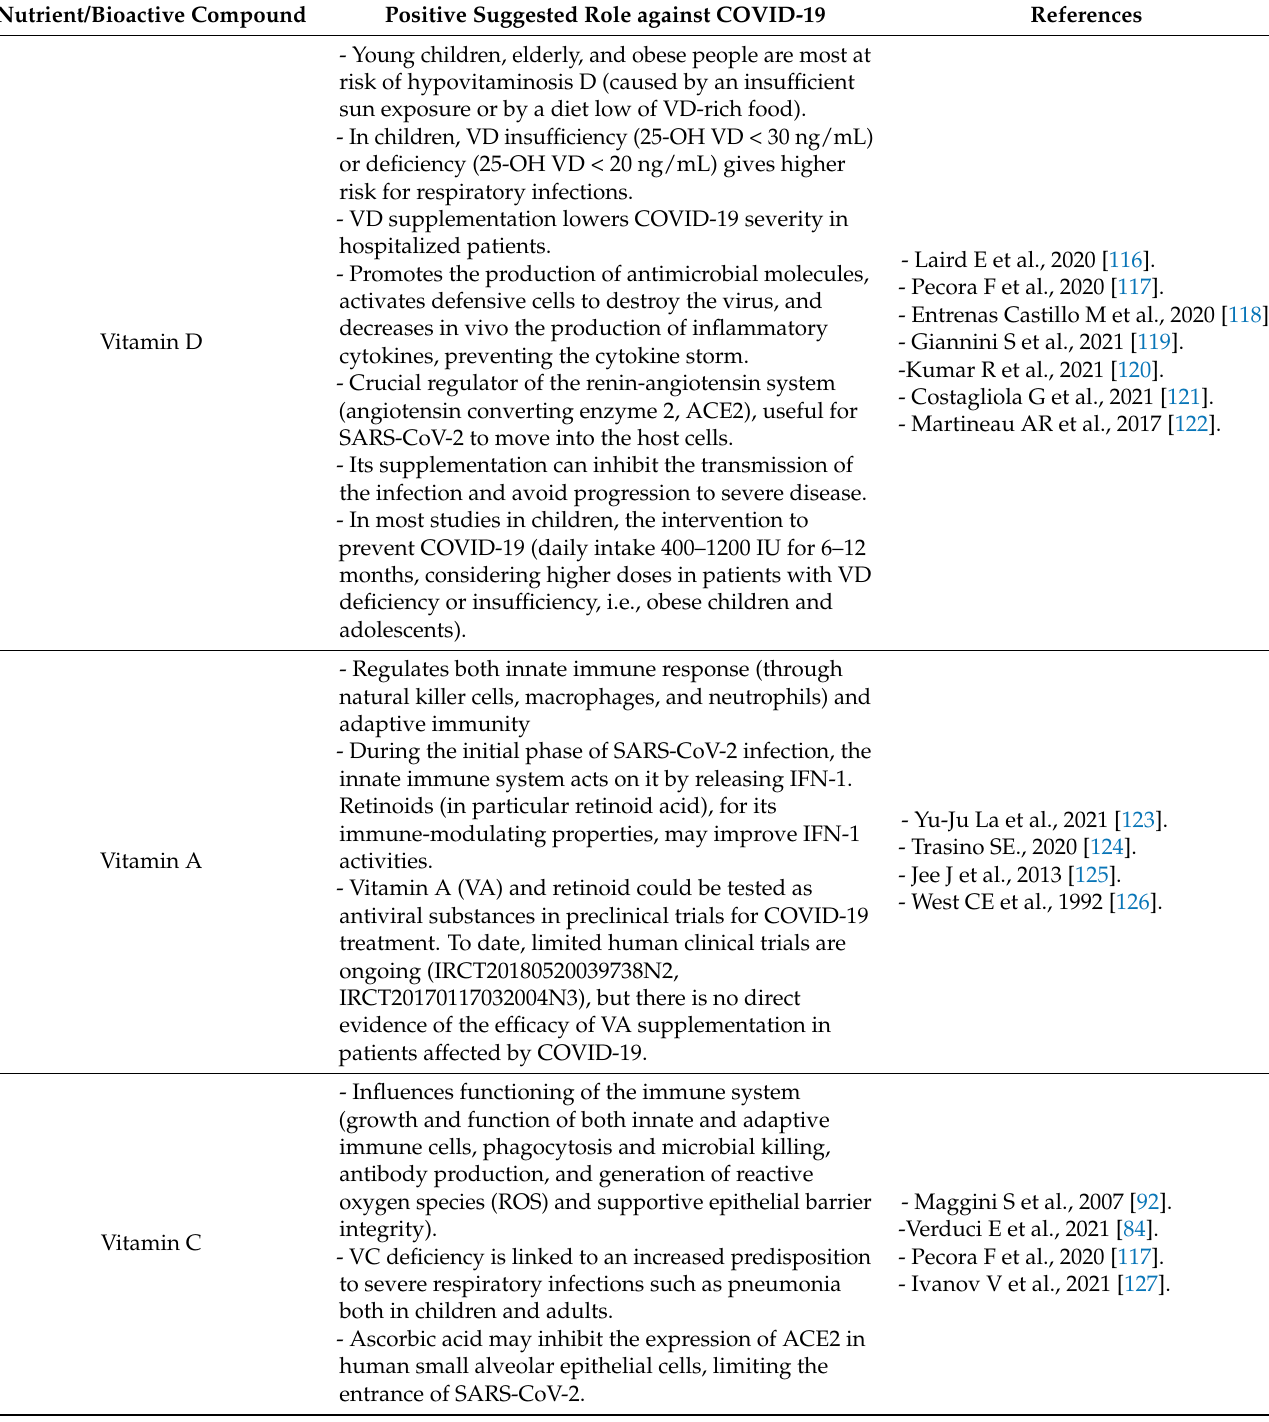
Table 1. Roles of some bioactive compounds against